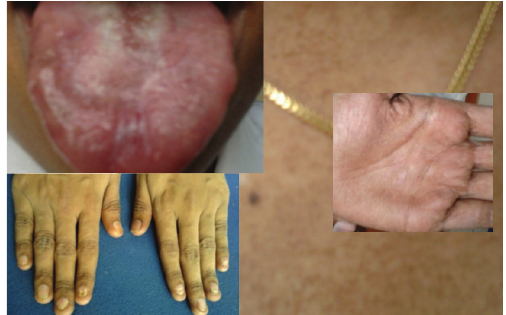
Figure 2: Case 2—clinical picture showing oral leukoplakia, nail dystrophy, and reticular pigmentation on neck and palm.